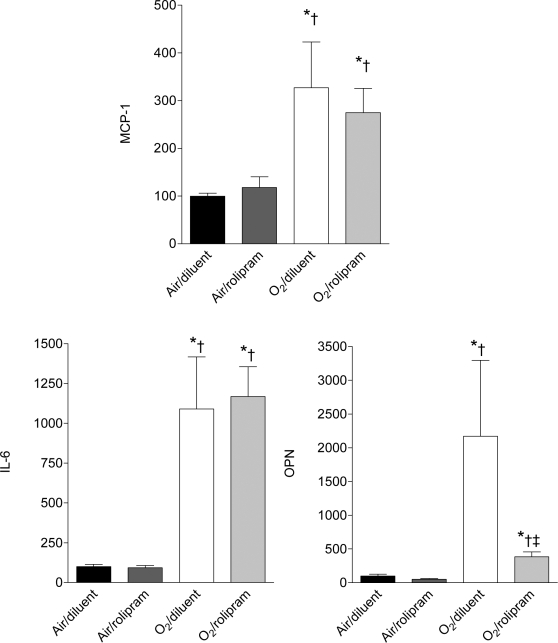
Steady-state mRNA levels of selected chemokine (MCP1) and cytokines (IL-6 and OPN) in whole lungs of rat pups exposed to hyperoxia treated with rolipram.Relative concentrations of MCP-1, IL-6, and OPN mRNAs were determined by real-time RT-PCR in whole lungs collected on day 6 of life from rat pups exposed to normoxia or hyperoxia from birth and either treated with rolipram (n = 4 or 5/group) or receiving the diluent alone (littermate controls, n = 4 or 5/group). Data are expressed as mean±sem. * Significantly different from the air-diluent group;†significantly different from the air-rolipram group; ‡ significant difference between oxygen-diluent and oxygen-rolipram groups.